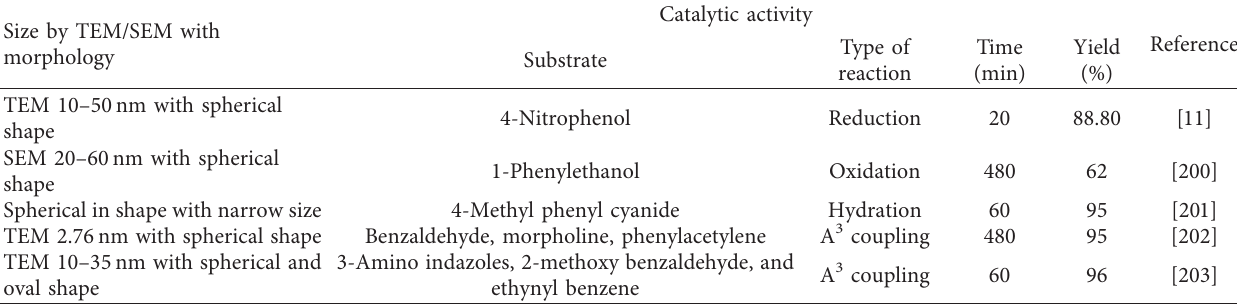
Table 8: Morphology of green synthesized Ag NPs and their catalytic activity on different